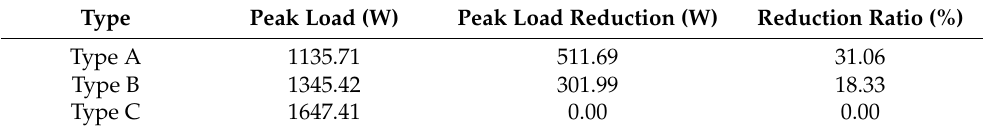
Table 2. Peak load reduction.